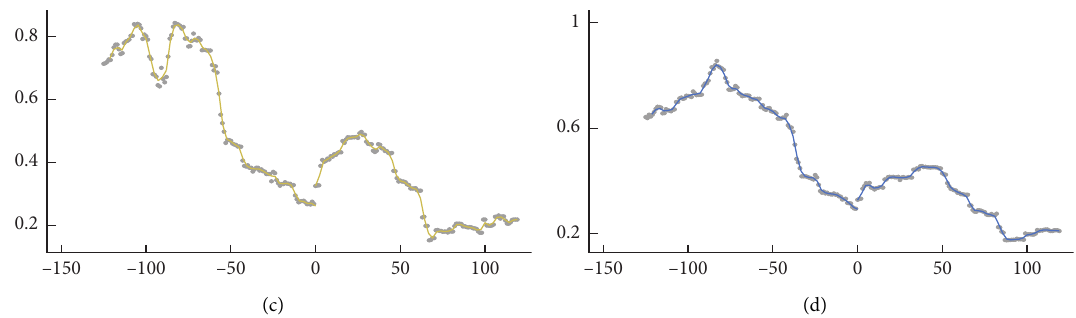
Figure 2: The RDD results of the telecommunications industry. (a) hv5, (b) hv15, (c) hv30, and (d)